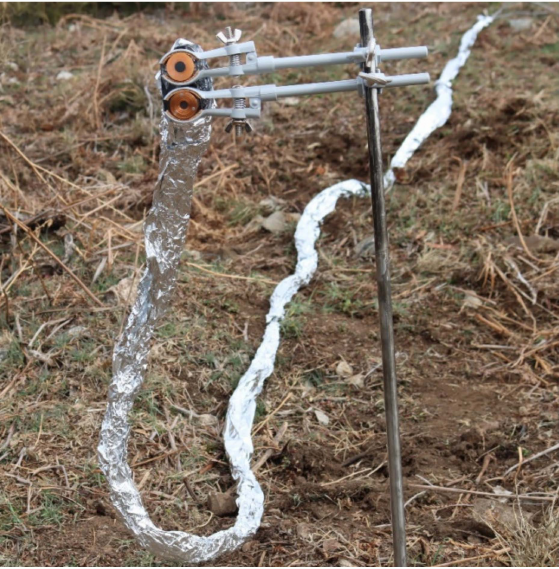
Figure 3. Radiant and total heat flux sensors fixed on supporting rod ahead of the vegetation plot and protected with aluminum